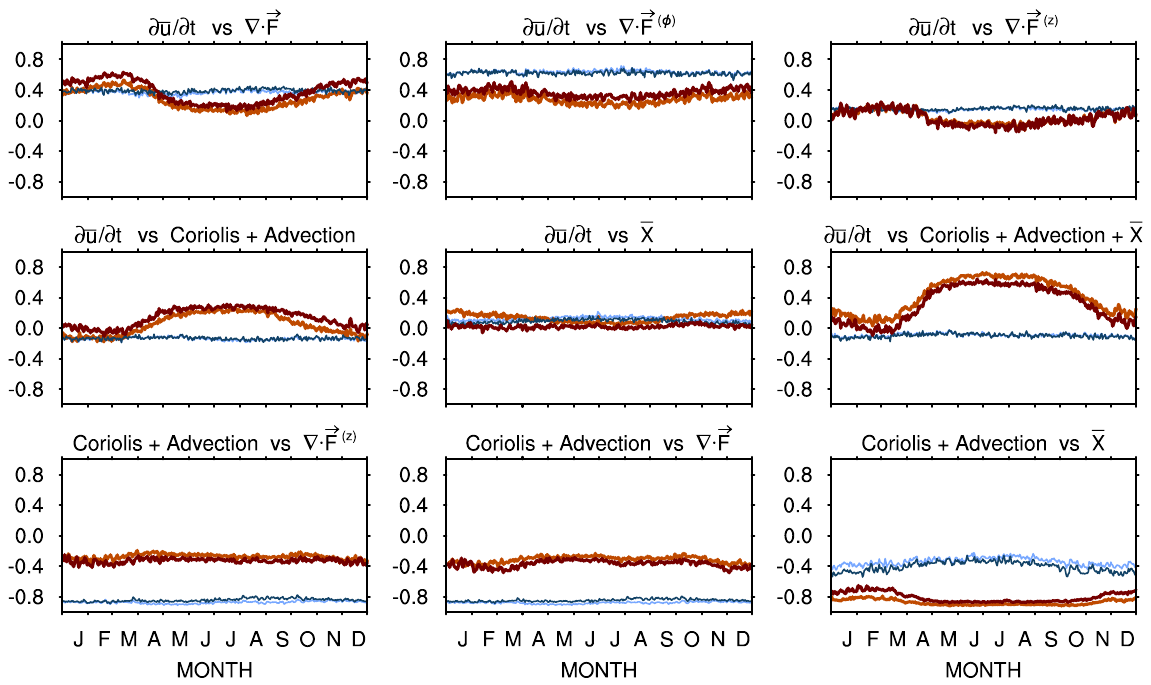
Fig. 6. Time variations of spatial correlation coefficients over the Northern Hemisphere in the troposphere (blue lines), up to 250hPa, and in the stratosphere (brown lines), between 150 and 20hPa, between the various terms of the TEM momentum equation for the ERA-40 (light) and R-2 (dark) reanalyses. Correlation coefficients are calculated every 6h over the time period 1 Jan 1980–31 Dec